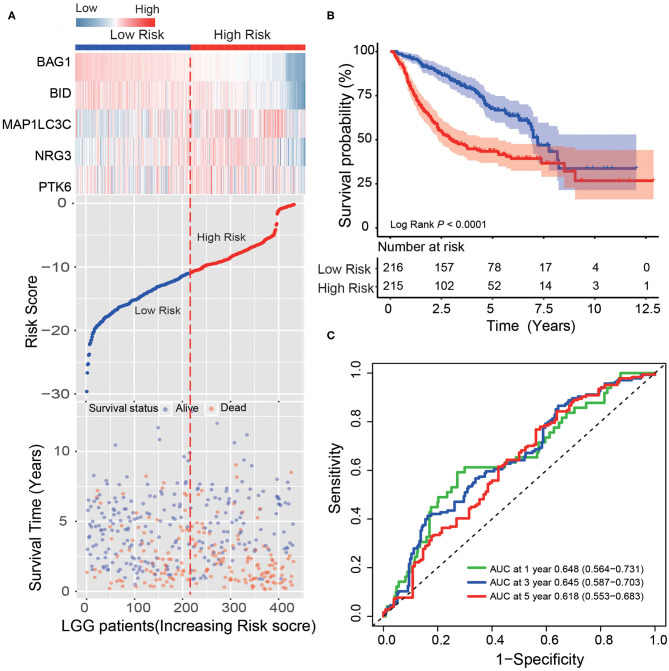
Validating survival prediction performance of the ATG signature in the test dataset. (A) Expression heatmap of the five ATGs, dot plot of risk scores and survival status of LGG patients in the test dataset. (B) Kaplan–Meier plot found that the five-ATG signature divided patients into high-risk and low-risk groups with different survival. (C) Time-dependent ROC analysis of the ATG signature in the test group.